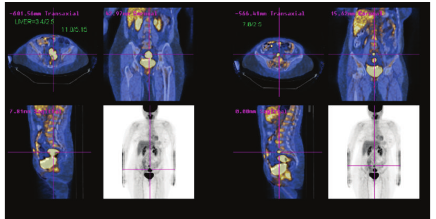
Figure 3: PET-CT showing a hypermetabolic rectosigmoid mass with multiple hypermetabolic enlarged lymph